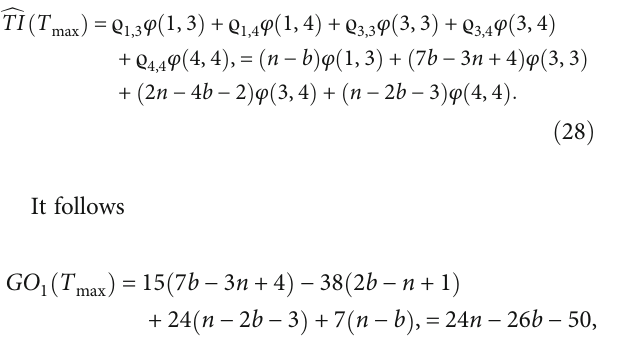
b = ð n − 2 Þ /2 20, b where